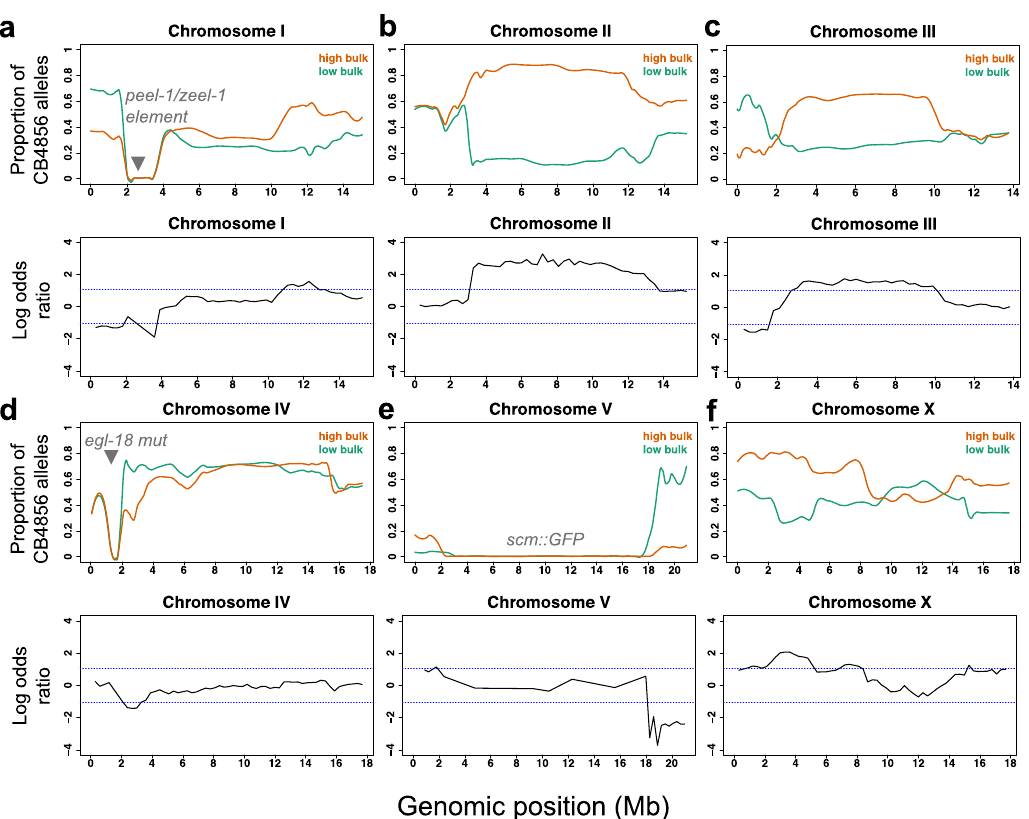
Fig. 3 Bulk segregant analysis of recombinant inbred lines. a – f Proportion of CB4856 SNPs in the sequencing reads of the low-seam cell number (SCN) bulk and high-SCN bulk groups is shown along the six chromosomes, from I a to X f . SNP frequencies in low-bulk and high bulk are shown in green and orange fi tted curves, respectively. The curves represent locally weighted scatterplot smoothing (LOESS) regression lines from the allele frequencies at known SNP positions along the chromosomes with a span parameter of 0.1. Log-odds ratio of average SNP frequencies in non-overlapping 300 kb windows along the six chromosomes is also shown. The blue dashed lines indicate the thresholds for statistical signi fi cance for log-odd ratios at α = 0.05. The positions of the peel-1/zeel-1 element, egl-18(ga97) mutation and scm::GFP transgene integrations are shown in grey. Negative LOD scores are obtained when the low-SCN bulk has a higher proportion of CB4856 SNPs compared to the high-SCN